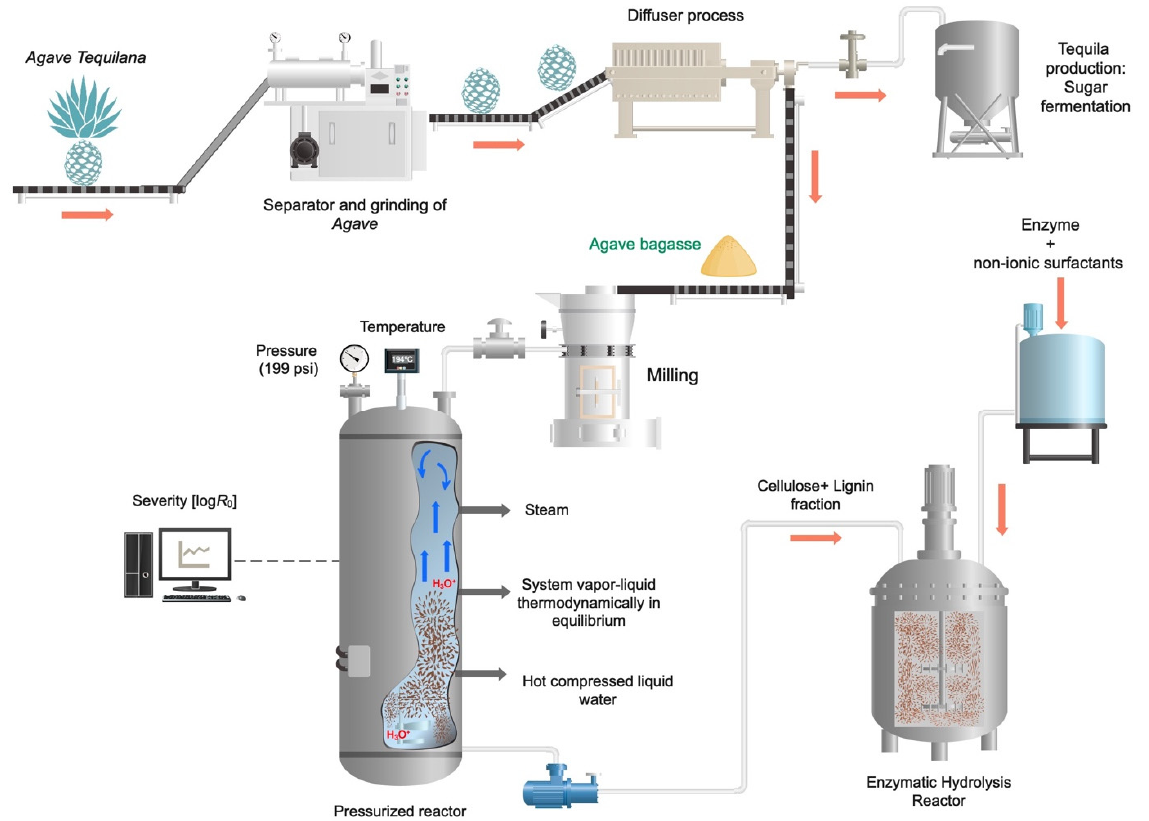
Figure 1. Schematic representation of the general process in the production of fermentable sugars using hot compressed liquid water pretreatment, agave bagasse, and non-ionic surfactants.